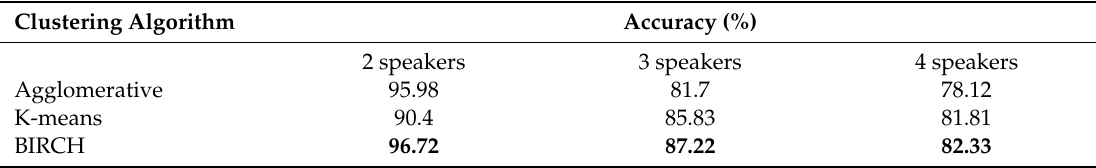
Table 2. Speaker diarization accuracy for unknown